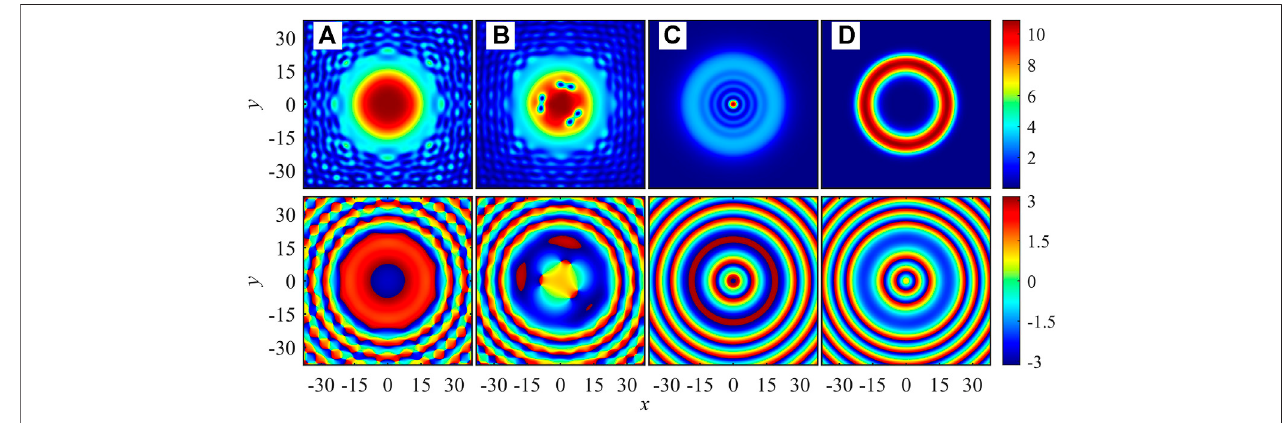
FIGURE 5 | (Color online) Steady-state distributions of polaritons density with the pump radius R (cid:2) 25. (A – D) : Decay ratios c c / c R (cid:2) 0 . 014 , 0 . 02 , 0 . 1 , 0 . 5, corresponding to locations marked by squares of III from left to right in Figure 1 , respectively.